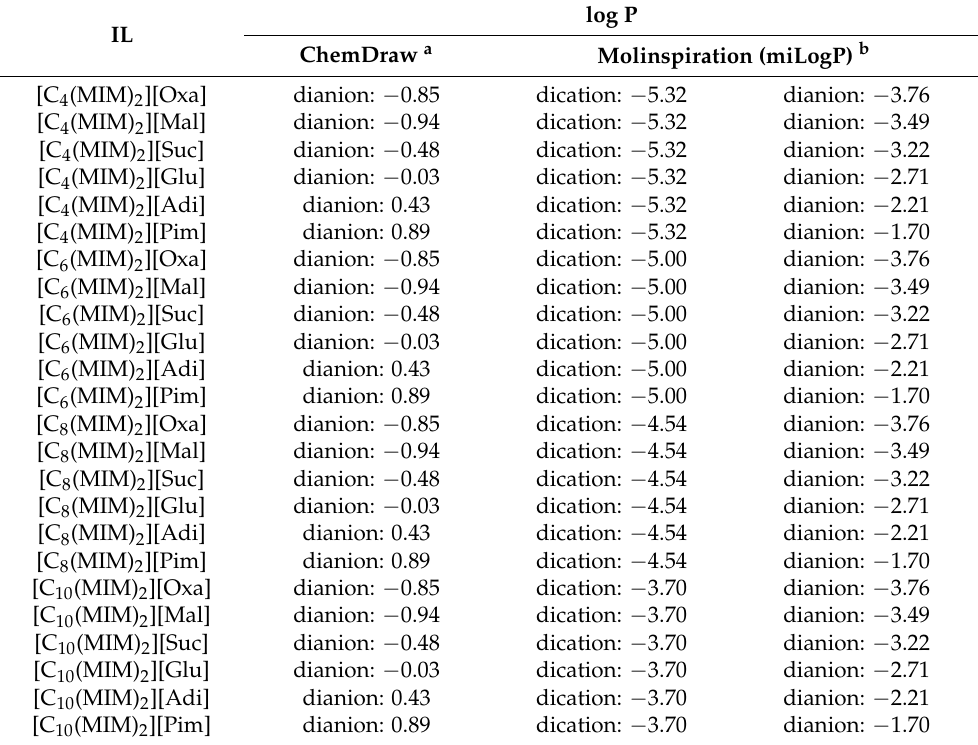
Table 3. log P values calculated by different